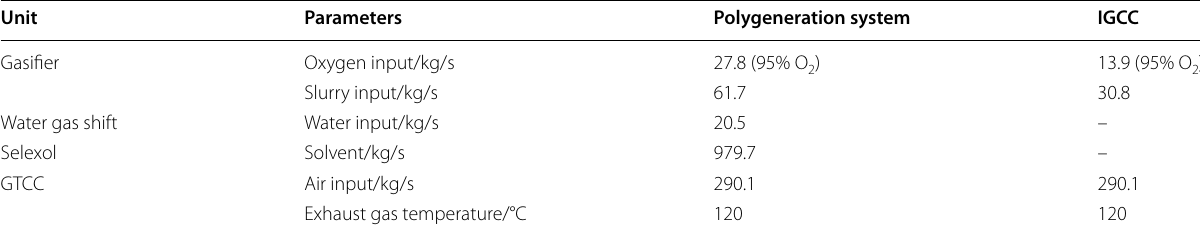
Table 4 Input parameters of the models under the design conditions